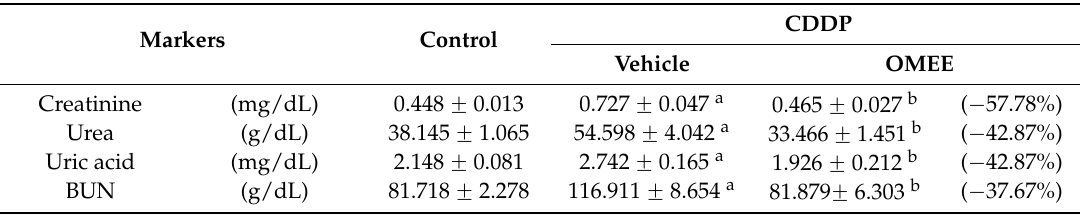
Table 1. Effect of Originum majorana ethanolic extract (OMEE) on Cis -Diaminedichloroplatinum (II) (CDDP)-induced